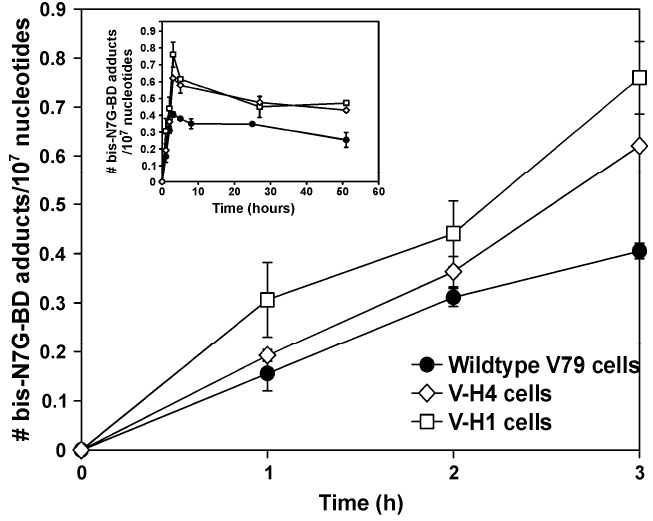
Figure 4. Time course for the formation (main panel) and repair (insert) of bis -N7G-BD cross-links in V79 (circles), V-H1 (squares), and V-H4 (diamonds) cells. Cells were exposed to 15 µM DEB for 1, 2, or 3 h. At the indicated times, chromosomal DNA was isolated, and bis -N7G-BD adduct levels were quantified by HPLC-ESI + -MS/MS as described in the Methods section. Results represent average ± the standard error of the mean, n = 2. Insert: ICL dynamics following DEB removal. Following treatment, DEB was removed and replaced with fresh growth media. DNA was isolated, and bis -N7G-BD adduct levels were determined as described above.